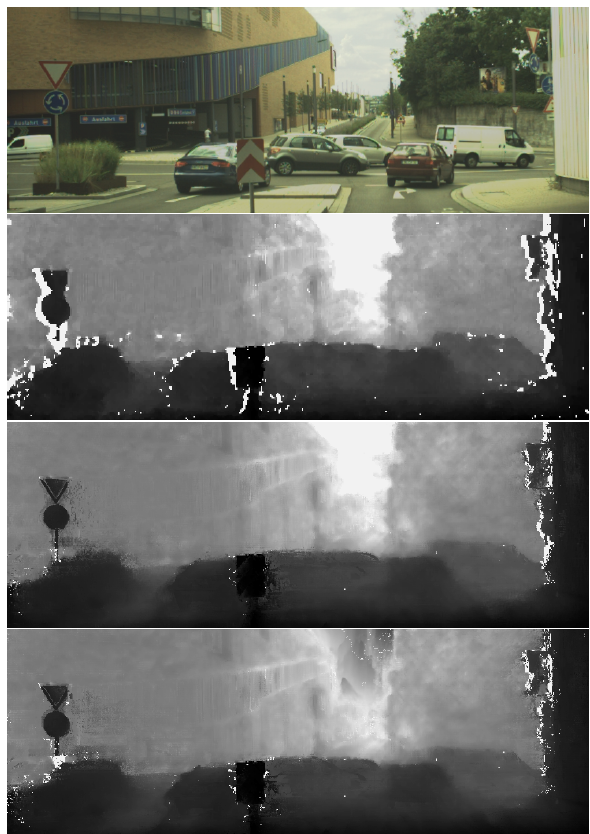
Figure 6. Picture detail of traffic scene. See fig. 3 for parameter description. Note the contours of the signs.